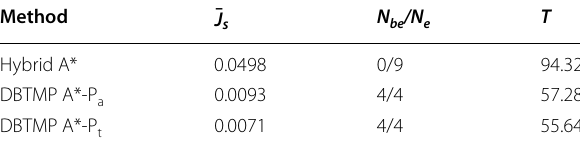
Table 4 Comparison of MP online selection results in a